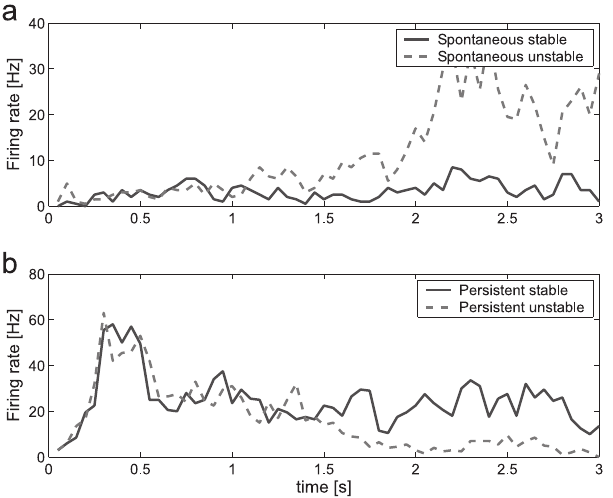
Figure 2. Example Trials of the Integrate-and-Fire Attractor Network Simulations (A) Trials in which no recall stimulus was applied to S1, and spontaneous firing continued until the end of the trial in the ‘‘ spontaneous ’’ simulation condition. However, on one of the trials illustrated, the firing increased as the network climbed into one of the attractors because of the statistical fluctuations caused by the spiking dynamics. (B) Trials in which a recall stimulus was applied to S1 at 0–500 ms, and continuing firing normally occurred until the end of the trial in the ‘‘ persistent ’’ simulation condition. However, on one of the trials illustrated, the firing decreased as the network fell out of the attractor because of the statistical fluctuations caused by the spiking dynamics. In these simulations, the network parameter is w þ ¼ 2.1, and the modulation of the synapses is (cid:2) NMDA and (cid:2) GABA. This corresponds to a reduction of 4.5% and 9% in the currents produced through these synapses, respectively. The average firing rate of all the neurons in the S1 pool is shown.